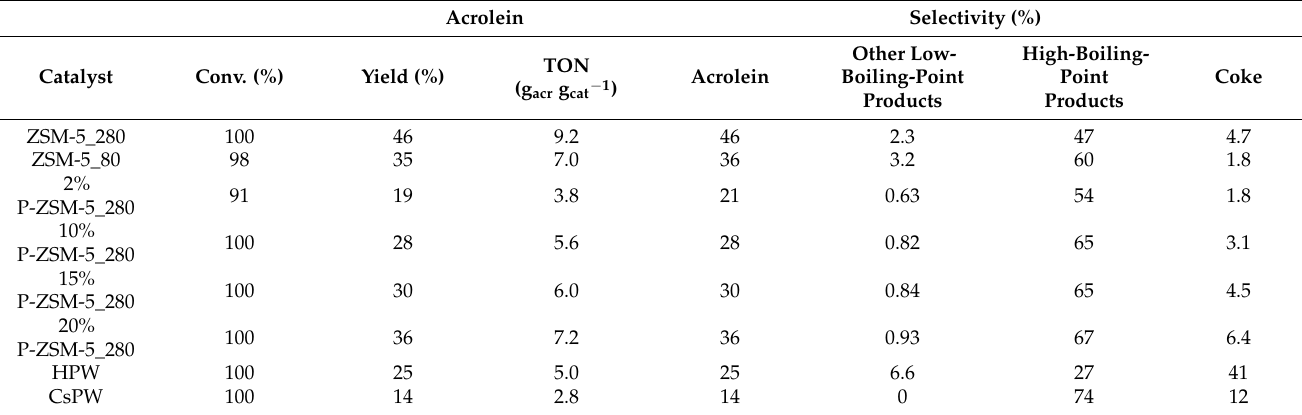
Table 6. Catalytic performance of various solid acids in liquid-phase dehydration of glycerol a